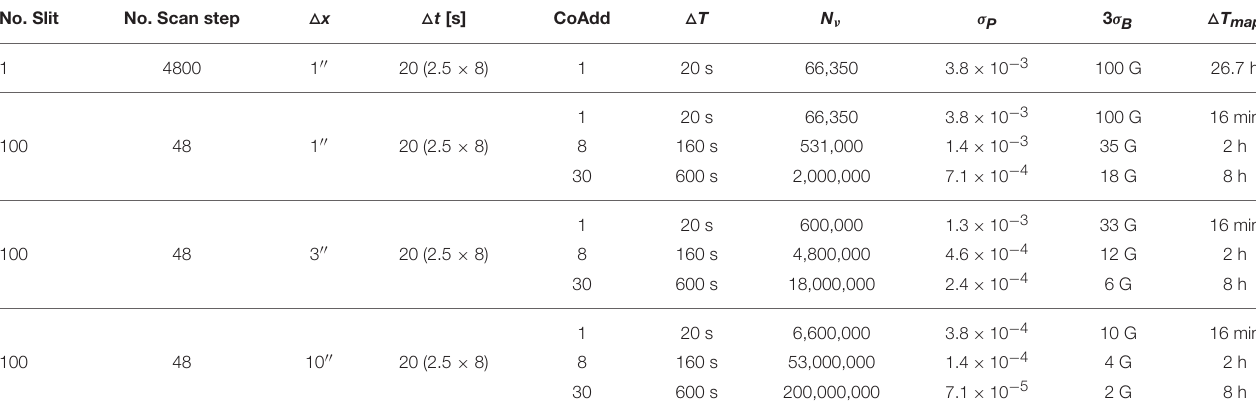
TABLE 2 | Estimates of continuum photon flux N ν , normalized photon noise level σ P , 3 σ longitudinal magnetic field detection limit B 3 σ , and total time △ T map required to scan a 1.2 × 1.0 degree FOV of mxCSM for the Fe XIII 1075 nm line polarimetric observations, assuming a 20% system efficiency, which includes the 50% transmission of the exit linear polarizer of the polarimeter, and a 10 × 10 − 6 I ⊙ scattered light background for coronal observation. No.